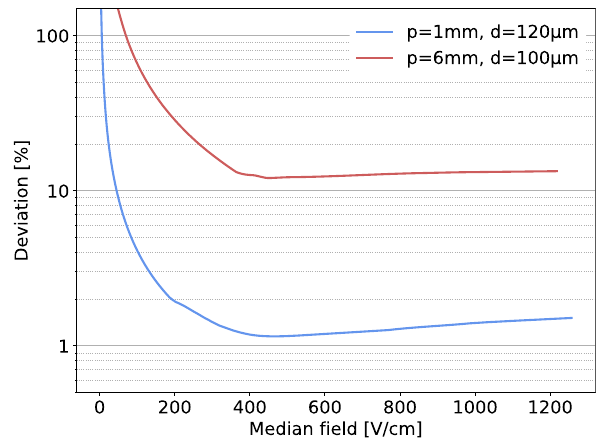
Fig. 4 Dependence of the electric field uncertainty (68% relative devi- ation) as a function of the applied drift field for two electrode designs. As expected, the simulated field for smaller pitched electrodes (blue line) shows a significantly smaller variation. Regions close to the elec- trodes are removed by a similar fiducial volume selection as used for the